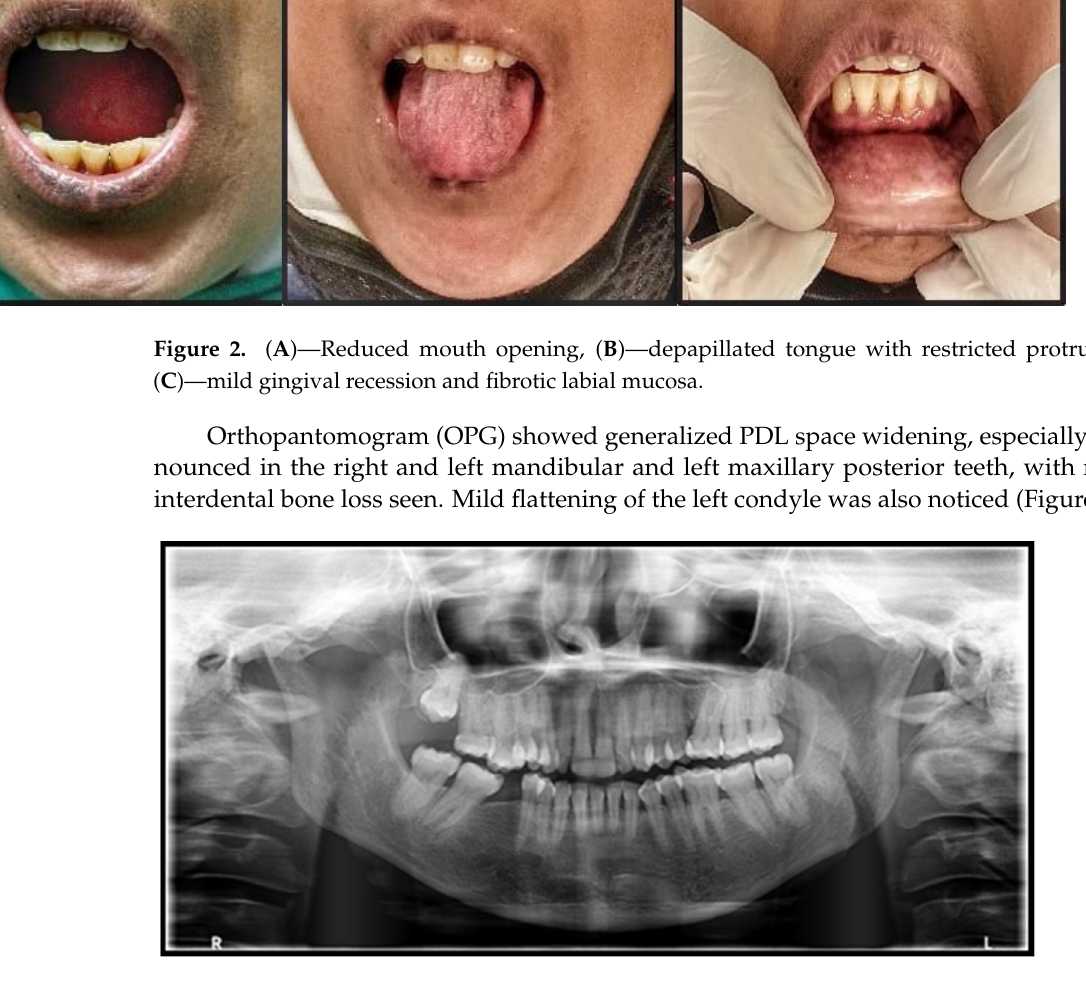
Figure 3. OPG reveals generalized PDL space widening. Mild flattening of the left condyle was also appreciated.